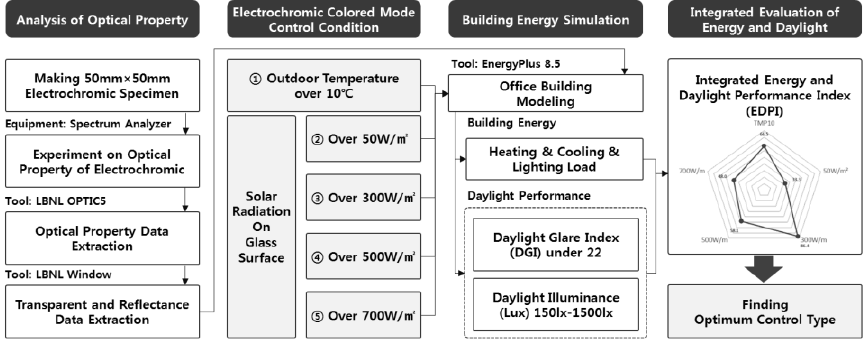
Figure 1. Research guideline and flowchart.